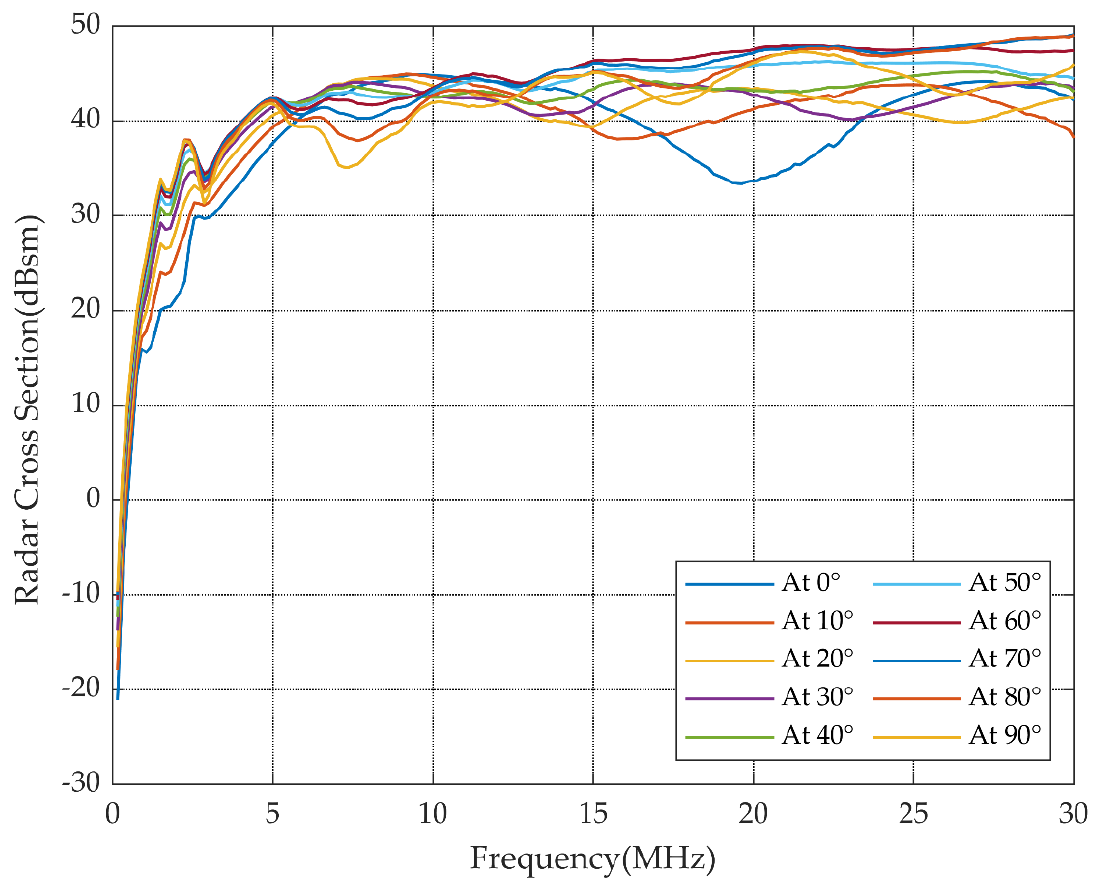
Figure 3. Scattering data in the frequency domain of the ship target at ten azimuths.